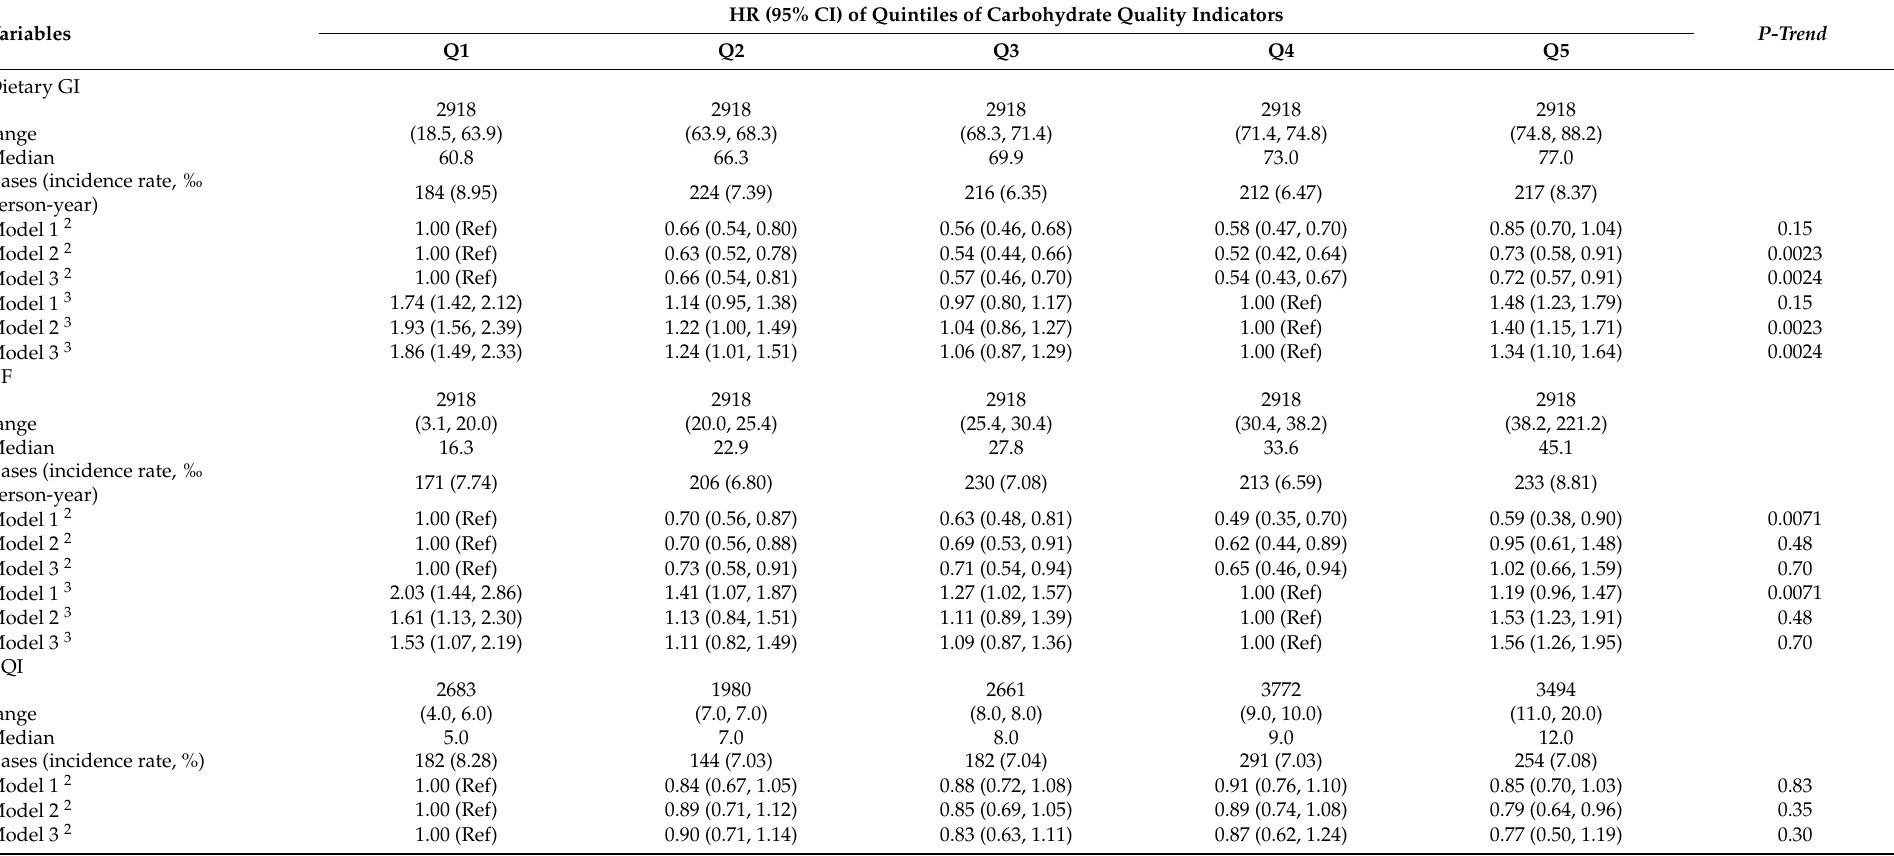
Table 2. Associations between dietary GI, CF and CQI values and T2DM risk in 14,590 Chinese adults of the China Health and Nutrition Survey 1997–2015 1